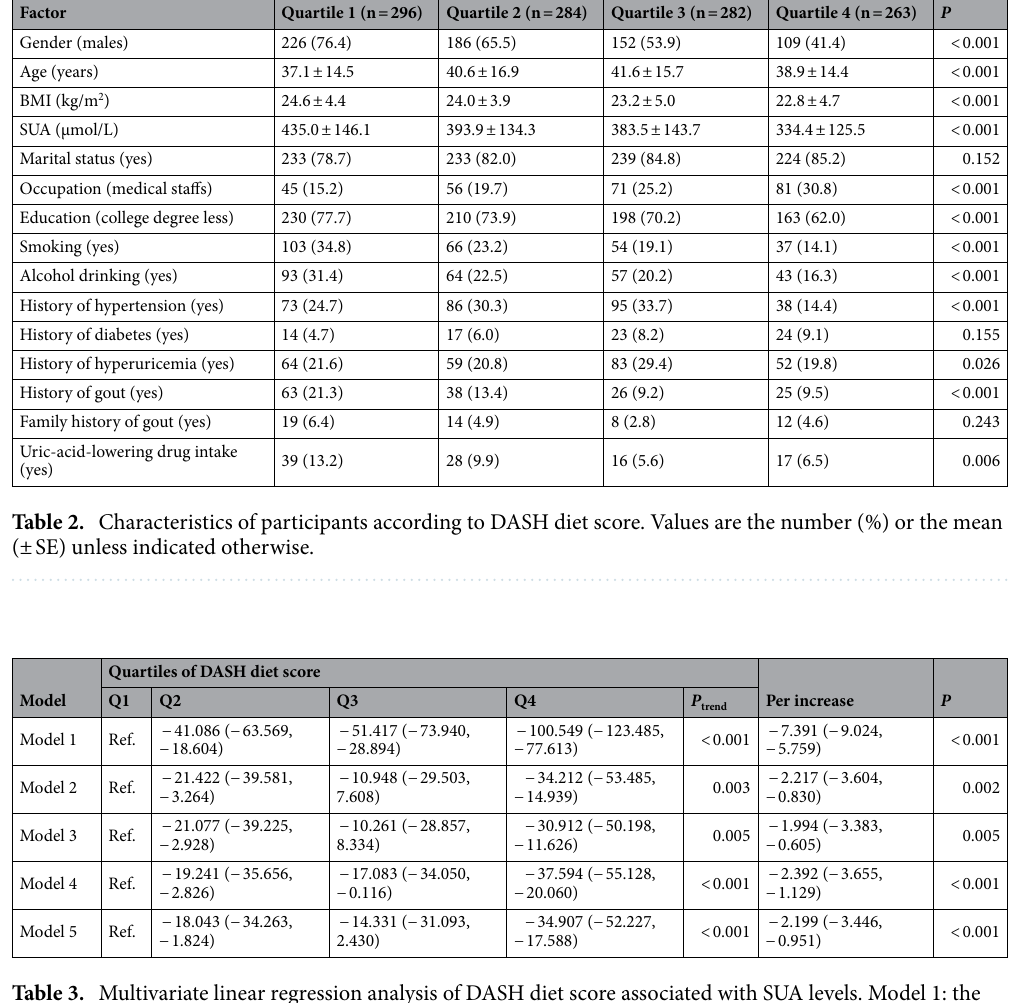
Table 3. Multivariate linear regression analysis of DASH diet score associated with SUA levels. Model 1: the primary model. Model 2: Adjusted for gender, age, married status, occupation, education level. Model 3: Based on Model 2, Adjusted for smoking, alcohol drinking, history of hypertension, history of diabetes. Model 4: Based on Model 3, Adjusted for history of hyperuricemia, history of gout, family history of gout, uric-acid- lowering drug intake. Model 5: Based on Model 4, Adjusted for